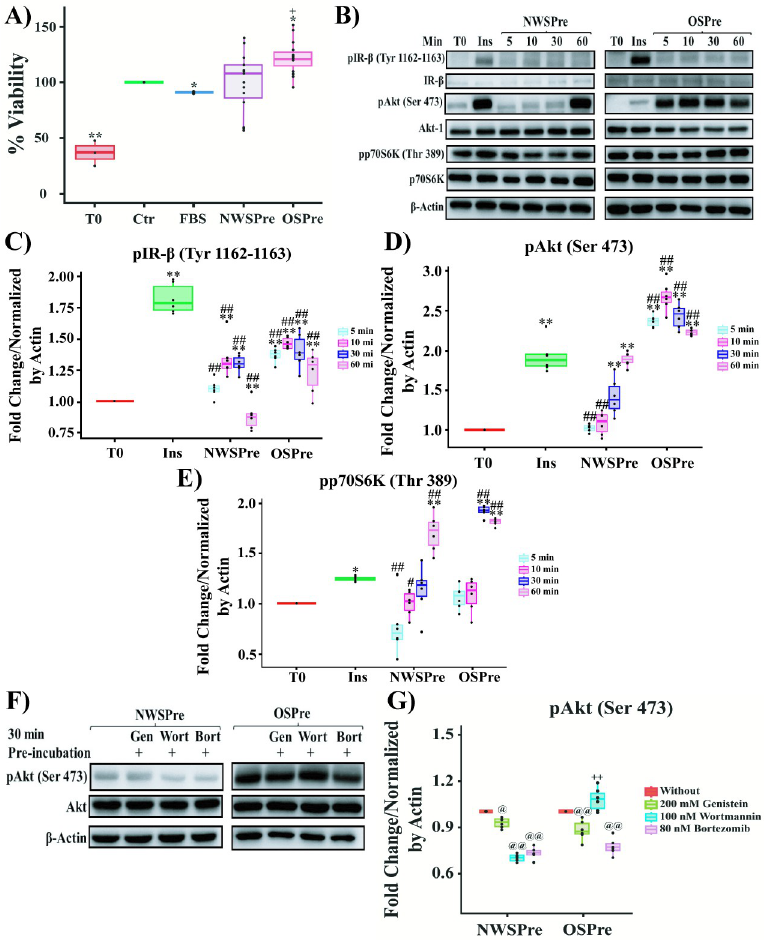
Fig 2. Effect of human sera on MCF-7 line. A) Viability of MCF-7 cells stimulated with sera from women with different BMI. B) Western Blot of the time course of IR- β /Akt/p70S6K pathway activation under stimulation with sera from women with different BMI. C) Group analysis of densitometric quantification stratified by sera condition of pIR- β (Tyr 1162–1163). D) Group analysis of densitometric quantification stratified by sera condition of pAkt (Ser 473). E) Group analysis of densitometric quantification stratified by sera condition of pp70S6K (Thr 389). F) Western Blot of Inhibition of Akt activation by stimulation with sera from women with different BMI. G) Group analysis of densitometric quantification of Inhibition of Akt activation by stimulation with sera from women with different BMI. For viability assay, the MCF-7 cells were treated with 10% inactivated fetal bovine serum (Ctr), 5% FBS or 5% sera from normal-weight premenopausal women (NWSPre) or sera from obese premenopausal women (OSPre). T0 corresponds to the viability at the time the different sera were added, and normalized against Ctr. For Western Blot, the cells were stimulated for 10 min with recombinant human insulin (Ins) (0.5 UI/ml) (positive control for activation), 5% NWSPre or 5% OSPre. T0 represents the phosphorylation level before stimulation with Ins or human sera. All experiments were carried out in triplicate (n = 9) for each serum evaluated. Comparison of means �� P < 0.005, � P < 0.05. �� Ctr or T0, ## 5% FBS or Ins, ++ NWSPre, @@ Without inhibitors.